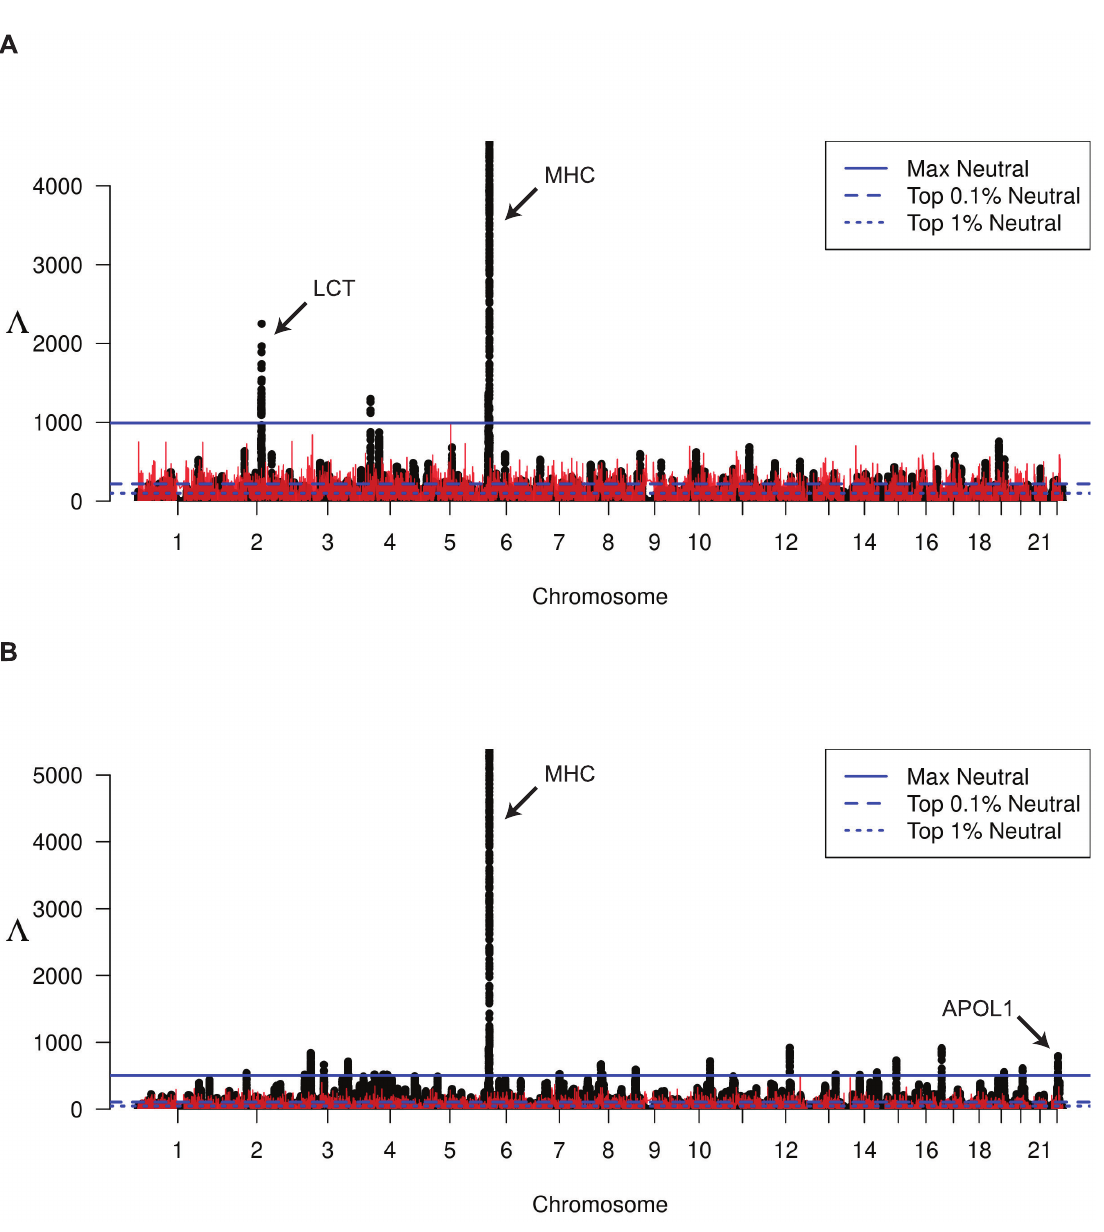
Fig 5. Manhattan plot of Λ -statistics. For the (A) CEU and (B) YRI populations from the 1000 Genomes Project. Each point represents a single 201-SNP window along the genome. Horizontal lines represent the top 1%, top 0.1%, and maximum observed Λ statistic across all windows in demography-matched neutral simulations. Red line indicates the maximum observed Λ among 100 replicate simulations at that location in the genome.